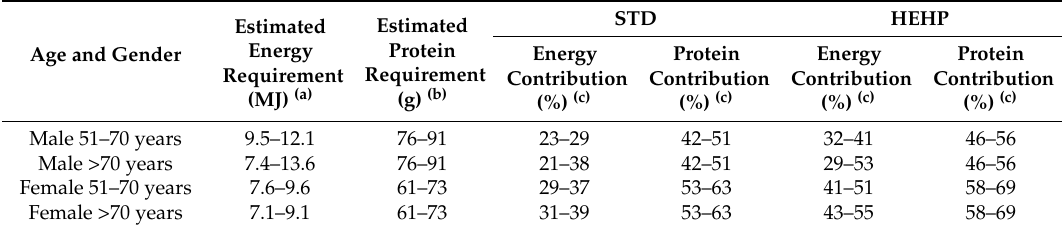
Table 4. Contribution of Standard and High Energy and Protein meals, as determined from the audit process, towards daily energy and protein requirements of older